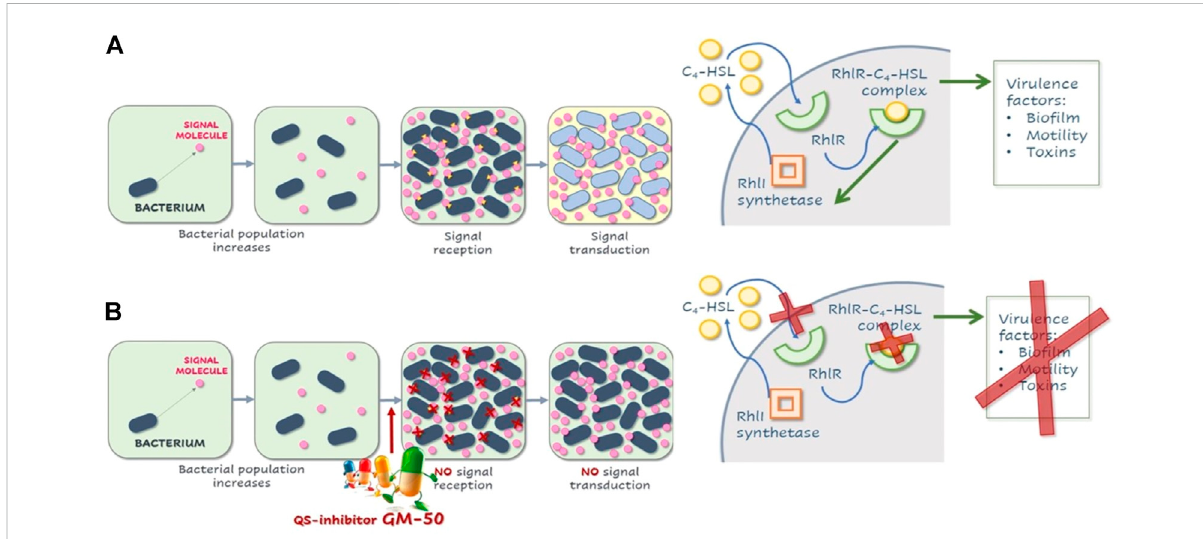
FIGURE 9 Schematic illustration of QS in P. aeruginosa and effects of GM-50. (A) Representation rhl quorum-sensing system in P. aeruginosa . After a threshold concentration of signal molecule C4HSL, the C4HSL-RhlR complex binds the promoter regions of responsive genes, activating or repressing their transcription. C4HSL-RhlR complex induces lasI expression, enhancing the production of C4HSL (autoinduction effect). Among virulence factors regulated by this pathway are genes involved in bio fi lm formation, pyocyanin and rhamnolipids release, elastase production, and swarming motility. (B) Compound GM-50 competes with C4HSL for the binding to the speci fi c receptor, thus reducing the expression of P. aeruginosa virulence genes even in the presence of autoinducers in the